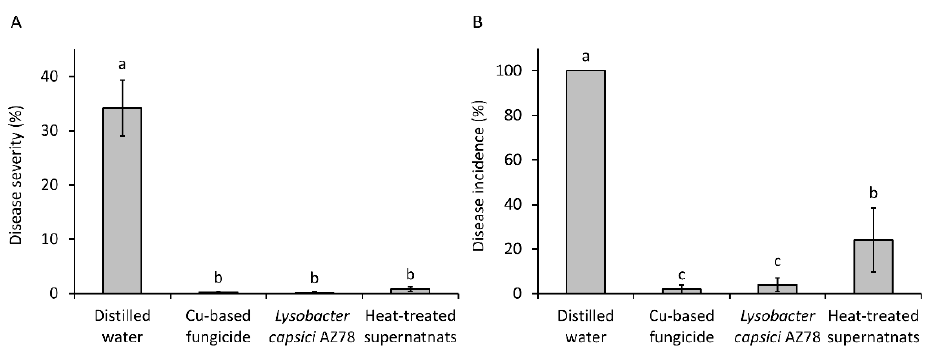
Figure 3. Control of Plasmopara viticola infection on grapevine leaf disks by the application of heat-treated Lysobacter capsici AZ78 (AZ78) cell-free supernatants. ( A ) Disease severity (% of leaf area covered by sporulating lesions), ( B ) Disease incidence (% of leaf disks showing symptoms). Twenty-four hours before the inoculum of Pl. viticola , grapevine leaf disks were treated with distilled water; copper-based fungicide; AZ78 cells; and heat-treated AZ78 cell-free supernatants. For each treatment, five Petri dishes containing five leaf disks were used. Data originating from two independent experiments were pooled and statistically analysed. Mean values ± standard deviations are reported for each treatment. Columns with the same letters do not differ significantly according to Tukey’s test ( α = 0.01).